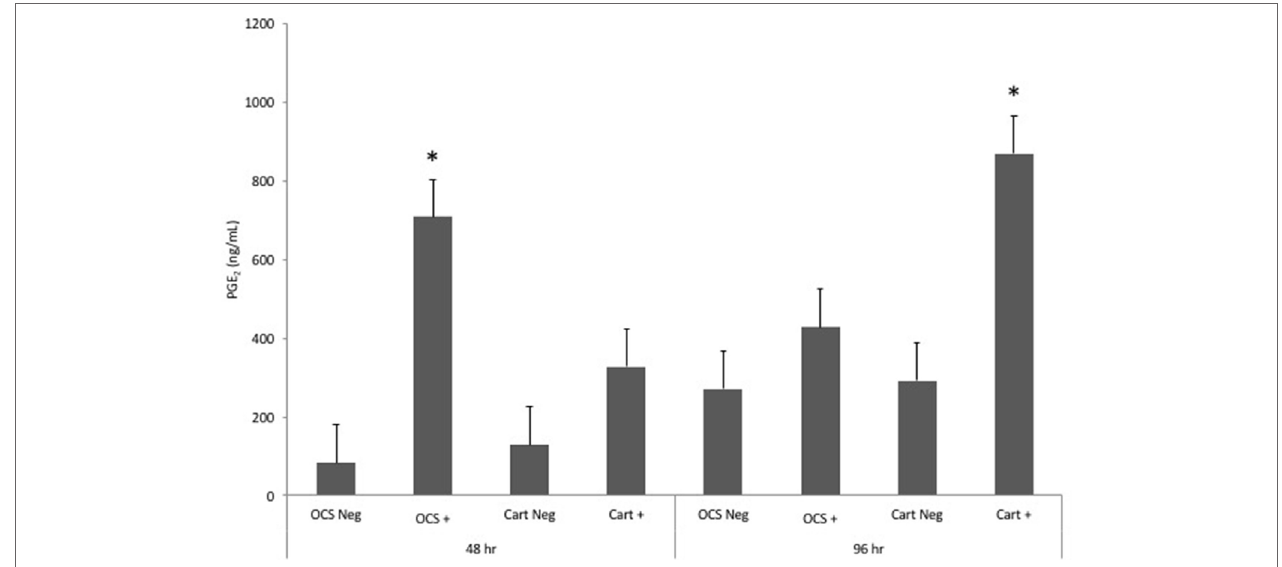
FigUre 1 | Mean ± SE concentrations of PGE 2 in media samples of cultures containing osteochondral and synovial explants (OCS) or cartilage explants alone (Cart) that were unstimulated (Neg) or stimulated with IL-1 (10 ng/mL; + ) at 48 and 96 h after initiation of treatments. *Within a culture type and time, concentration for IL-1-stimulated culture is significantly different from than that for the unstimulated